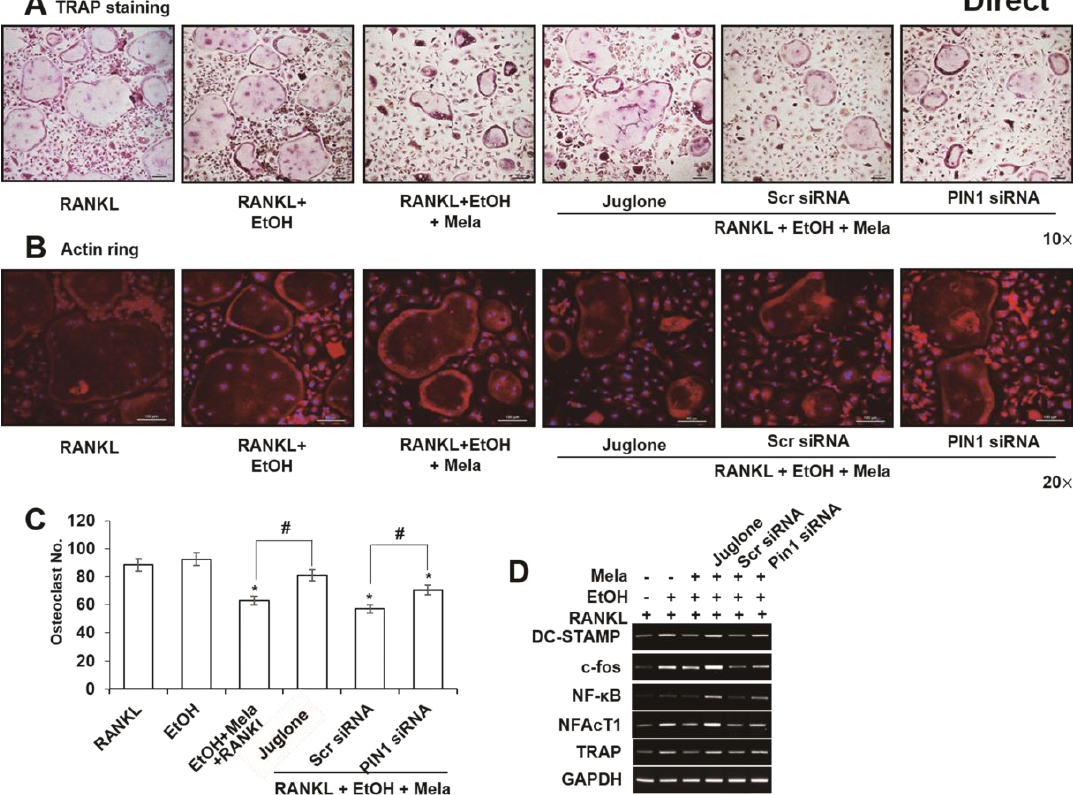
Figure 8. Direct effects of melatonin on EtOH-induced osteoclastic differentiation in BMMs. BMMs were stimulated with RANKL in the presence of juglone (50 nM) or PIN1 siRNA (30 nM), EtOH (25 mM) and melatonin (100 μM) for 5 days. In vitro osteoclatogenesis was accessed by TRAP staining ( A ) and actin ring staining ( B ), counting of osteoclast ( C ), mRNA expression of osteoclast-specific marker genes ( D ). Similar data were obtained from three independent experiments. *: statistically significant difference compared to the control groups ( p < 0.05). # : statistically significant difference in each group.